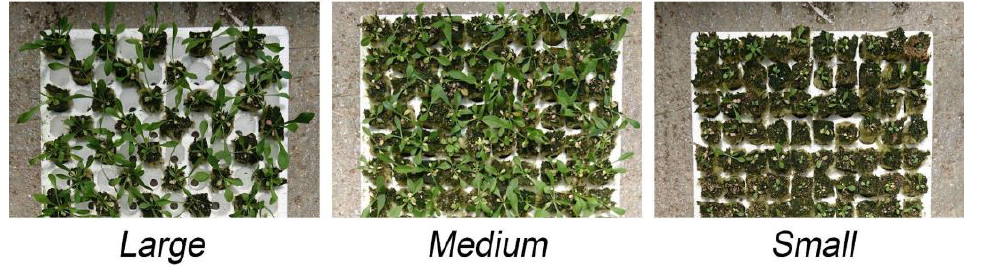
Figure 2. Separating the seedling into 3 groups based on their size and leaf number before transplanting them to the tanks.